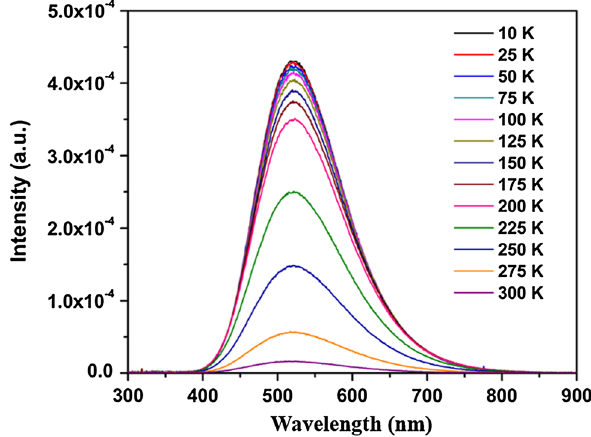
Fig. 4 Luminescence spectra of a NWO crystal at different tempera- tures